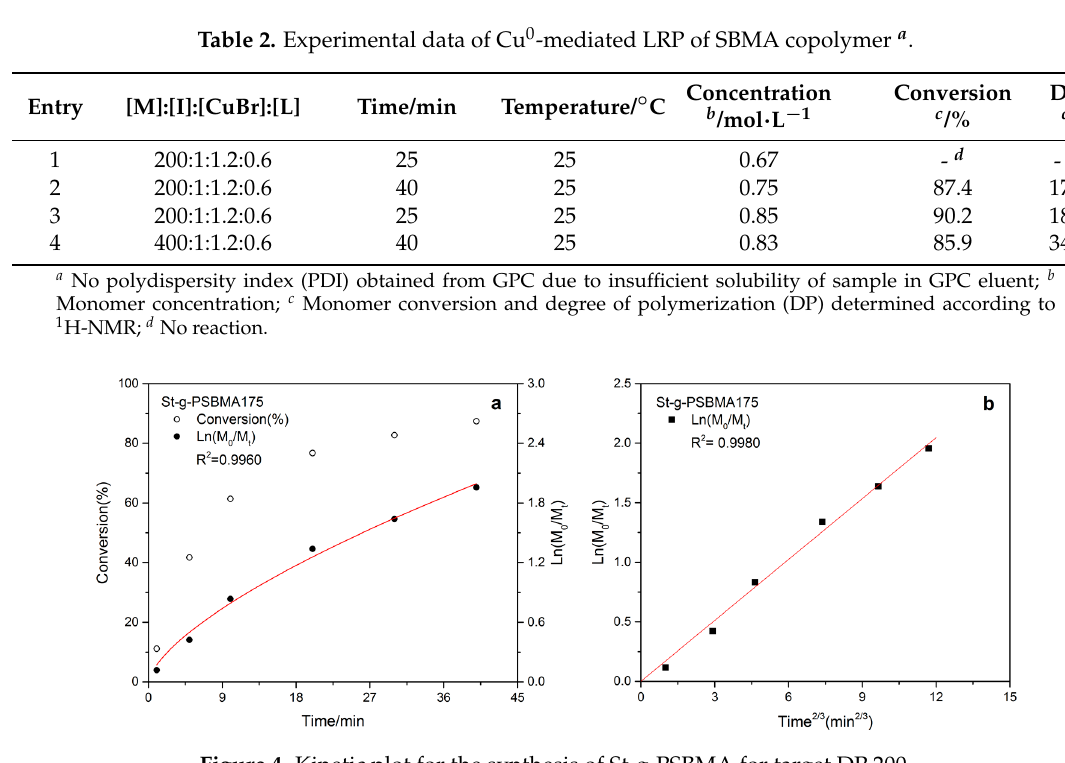
Figure 5 . Solution viscosity vs. salt concentration (( a ) shear rate 9.6 s − 1 ) and solution viscosity vs. shear rate ( b ).